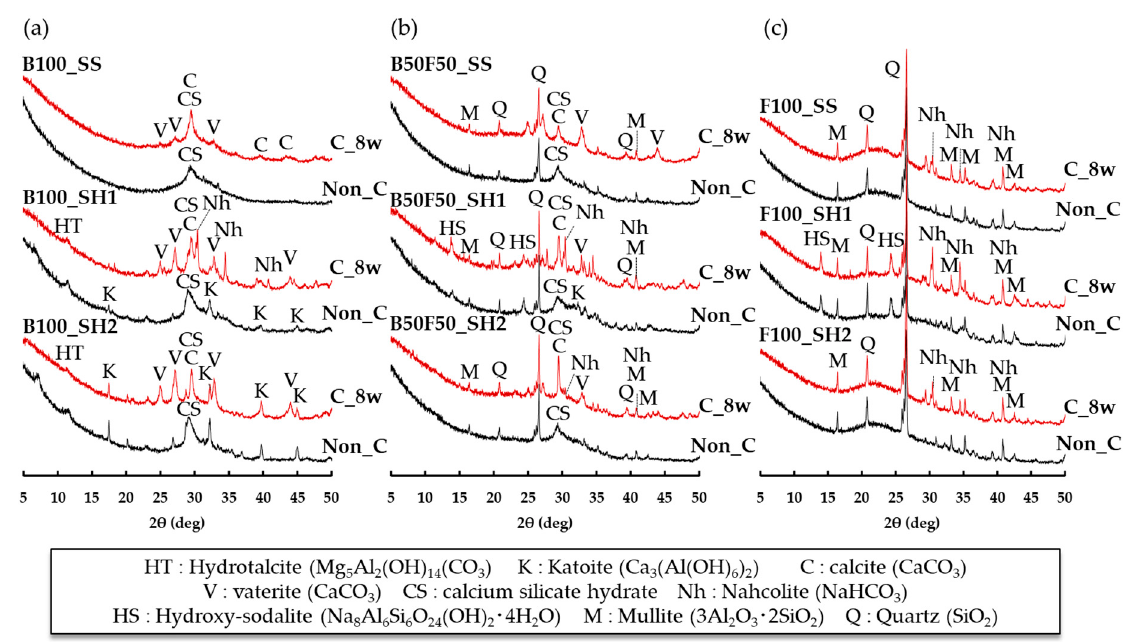
Figure 6. XRD results for paste specimens of ( a ) B100_SS, B100_SH1 and B100_SH2, ( b ) B50F50_SS, B50F50_SH1 and B50F50_SH2, and ( c ) F100_SS, F100_SH1 and F100_SH2, Non_C: 8 weeks, C_8w: 16 weeks (carbonation of 8 weeks).